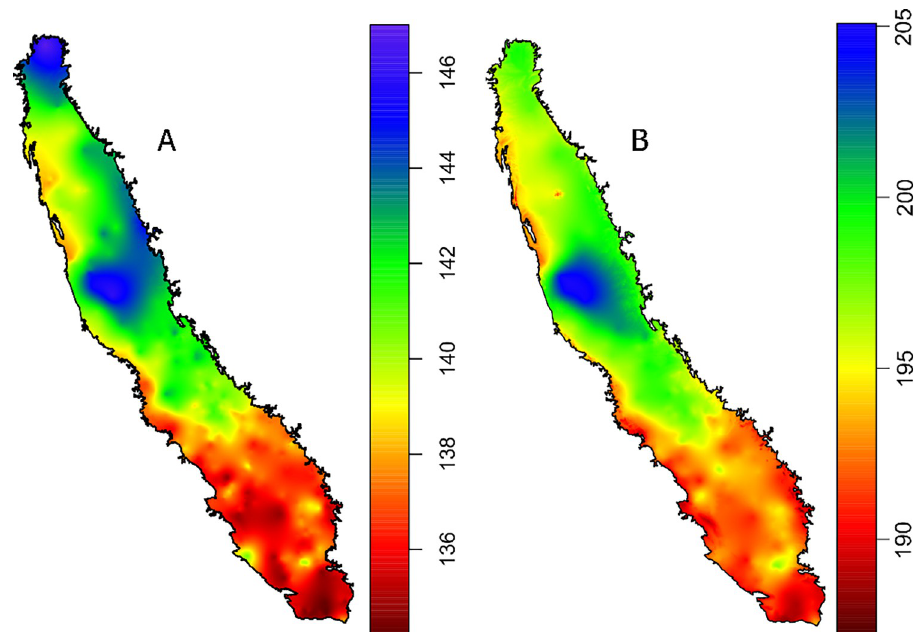
Fig 6. Interpolation of Grape (cv. Chardonay) 50% flowering prediction assuming a heat requirement of 1217 GDD